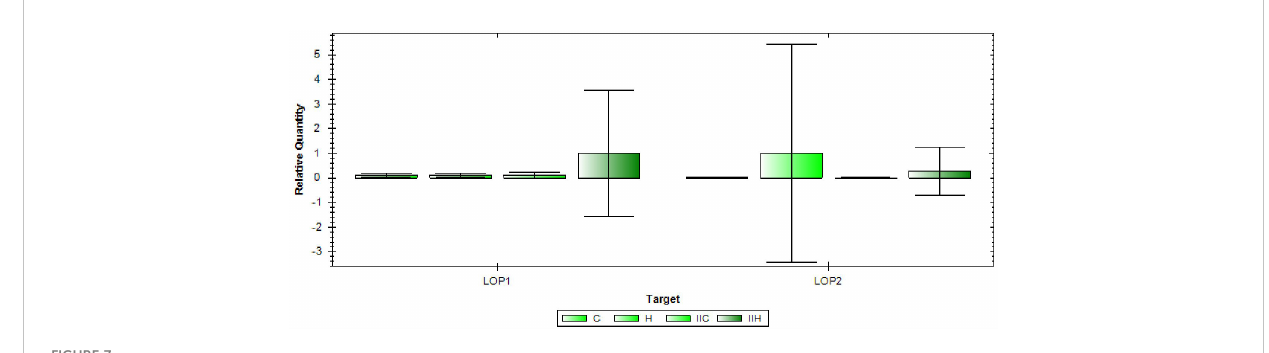
FIGURE 7 Gene expression of LOP1 and LOP2 [(C — Uma (control), H — Uma (high temperature), IIC-NL-44 (control), IIH-NL-44 (high